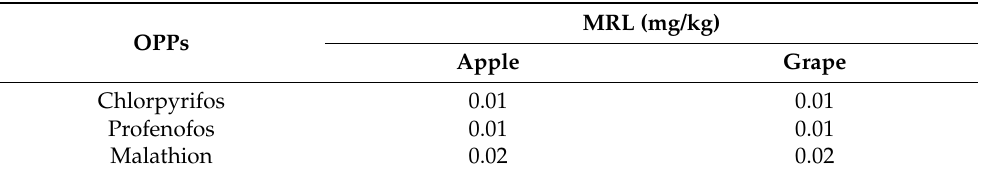
Table 2. Maximum residue level (MRL) of OPPs in fruits (European Union (EU) Regulations (EC) No. 2020/1085, No. 2017/978, and No.